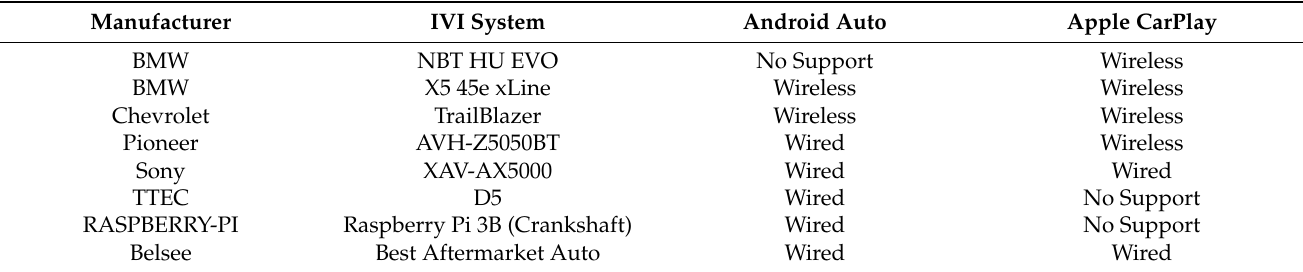
Table 1. IVI system used in case studies and connectivity of the IVI system.